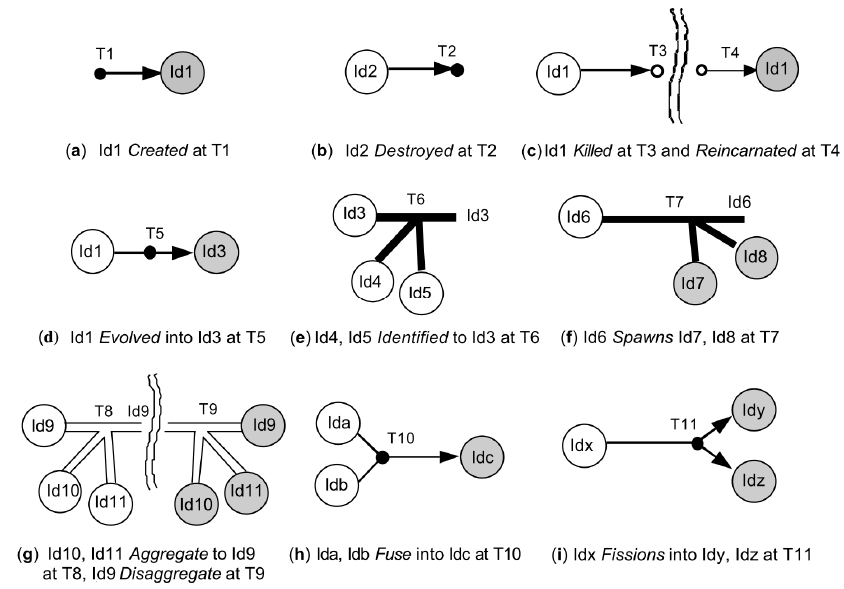
Figure 4. Transitions of the temporal constructs model ( [89] reproduced from [92] ).